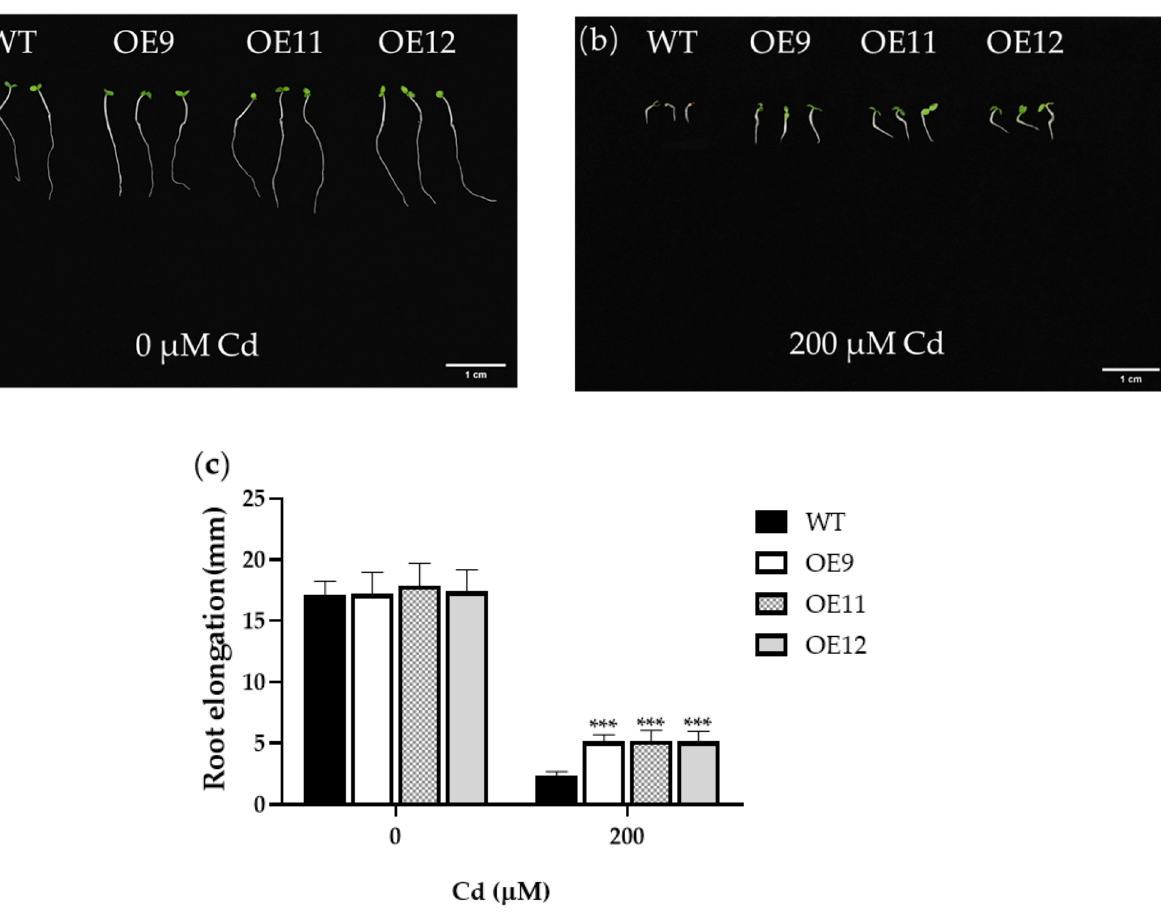
Figure 2. Effects of Cd stress in transgenic and WT seedlings. ( a ) Phenotypic comparison of the WT and transgenic lines under 0 μ M Cd 2+ . ( b ) Phenotypic comparison of WT and transgenic lines under 200 μ M Cd 2+ . ( c ) Root elongation of the WT and transgenic seeds ( n = 30). WT: Wild-type tobacco. OE9, OE11, and OE12: Three homozygous transgenic tobacco lines (T 2 ). Transgenic and WT seedlings were grown in Hoagland nutrient solution containing 0 or 200 μ M Cd 2+ for 3 d. Asterisks indicate the significant difference between OE lines and WT (***, p < 0.001).